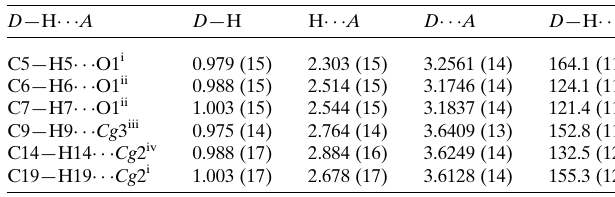
Table 1 Hydrogen-bond geometry (A˚ , (cid:2) ).